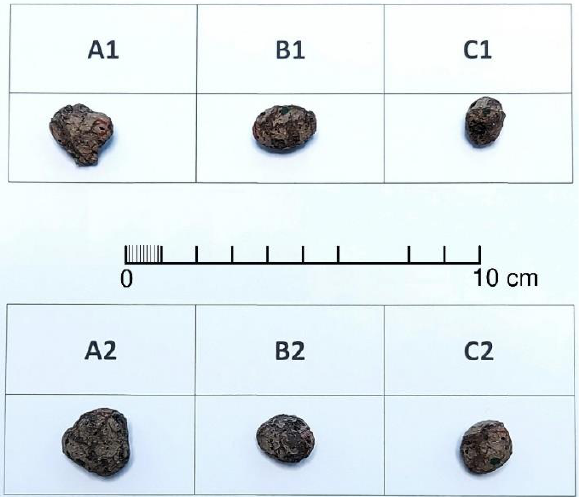
Figure 1. Six LECA grains selected for analysis: two subangular ( A1 , A2 ), two subrounded ( B1 , B2 ), and two rounded ( C1 , C2 ). and two rounded ( C1 , C2